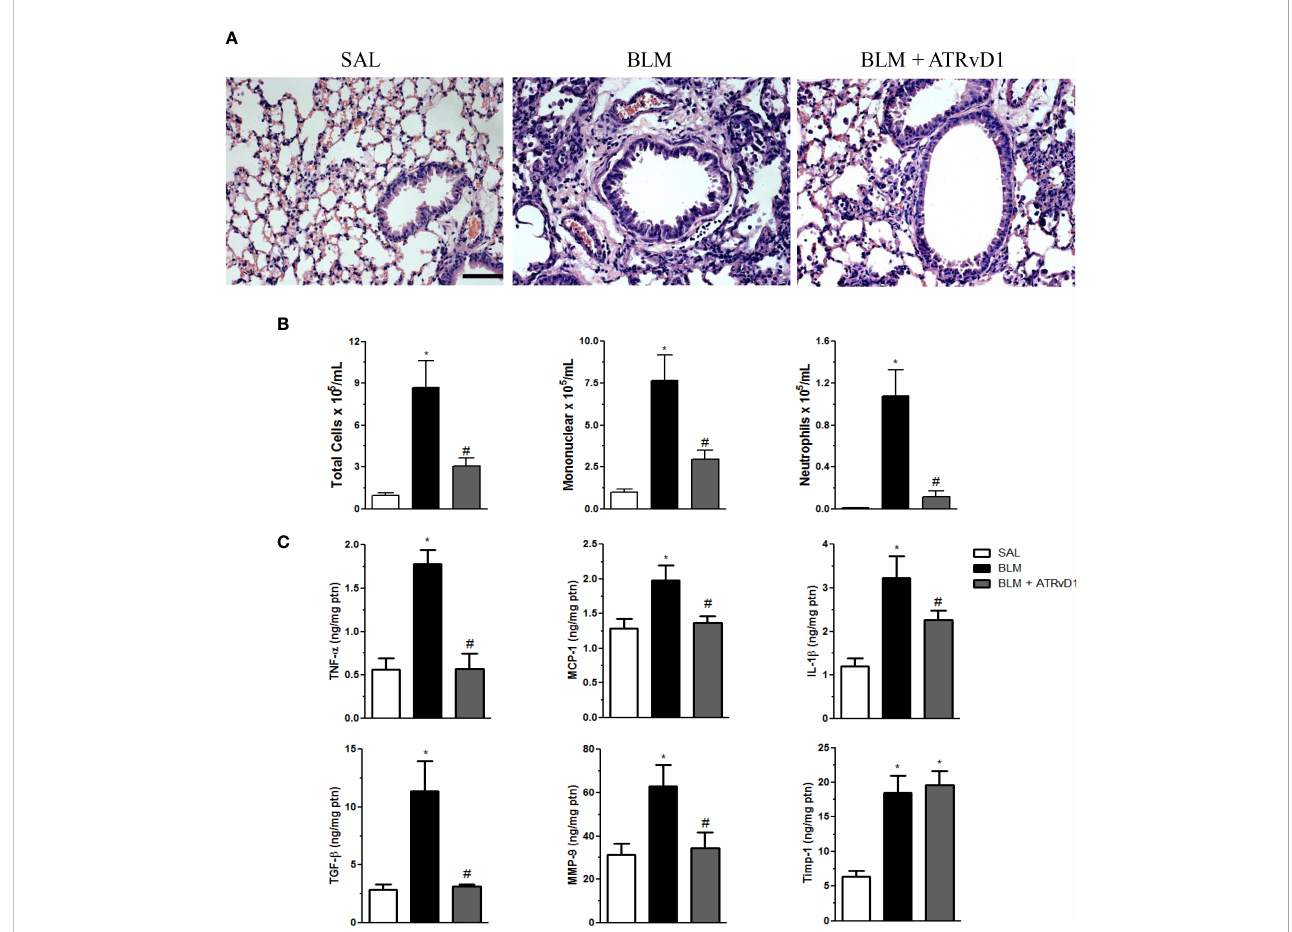
FIGURE 1 ATRvD1 treatment restores bleomycin (BLM)-induced lung morphology and in fl ammation. (A) Representative lung sections from saline (SAL) (left), BLM (center; 0.06 U/mouse in a fi nal volume of 30 m l of SAL), and BLM plus ATRvD1 treatment (right; on day 7, 2.5 m g/kg and a booster on day 10 with 0.5 m g/kg) obtained 14 days after BLM injection and stained with hematoxylin and eosin. Scale bar = 50 m m. (B, C) In fl ammatory cells and cytokines, MMP-9, and TIMP-1 were quanti fi ed in the BAL fl uid and lung tissue, respectively, 14 days after SAL, BLM, or BLM plus ATRvD1 treatment as described in (A) . Results represent mean + SEM from two independent experiments. * P ≤ 0.05 vs. the SAL group; # P ≤ 0.05 vs. the BLM